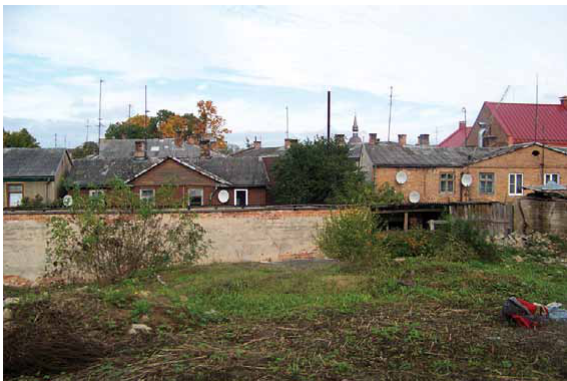
Fig. 6. The roof landscape of the old Town. Source : author’s photo, 2012.